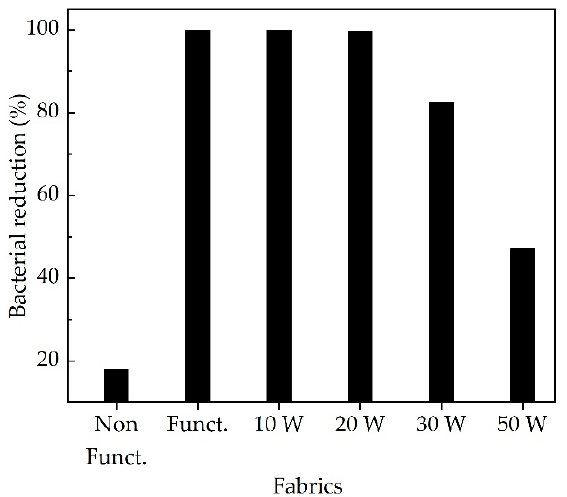
Figure 6. Results of a percentage of bacterial reduction for Escherichia coli (ATCC 25922), according to ASTM E2149 standard.